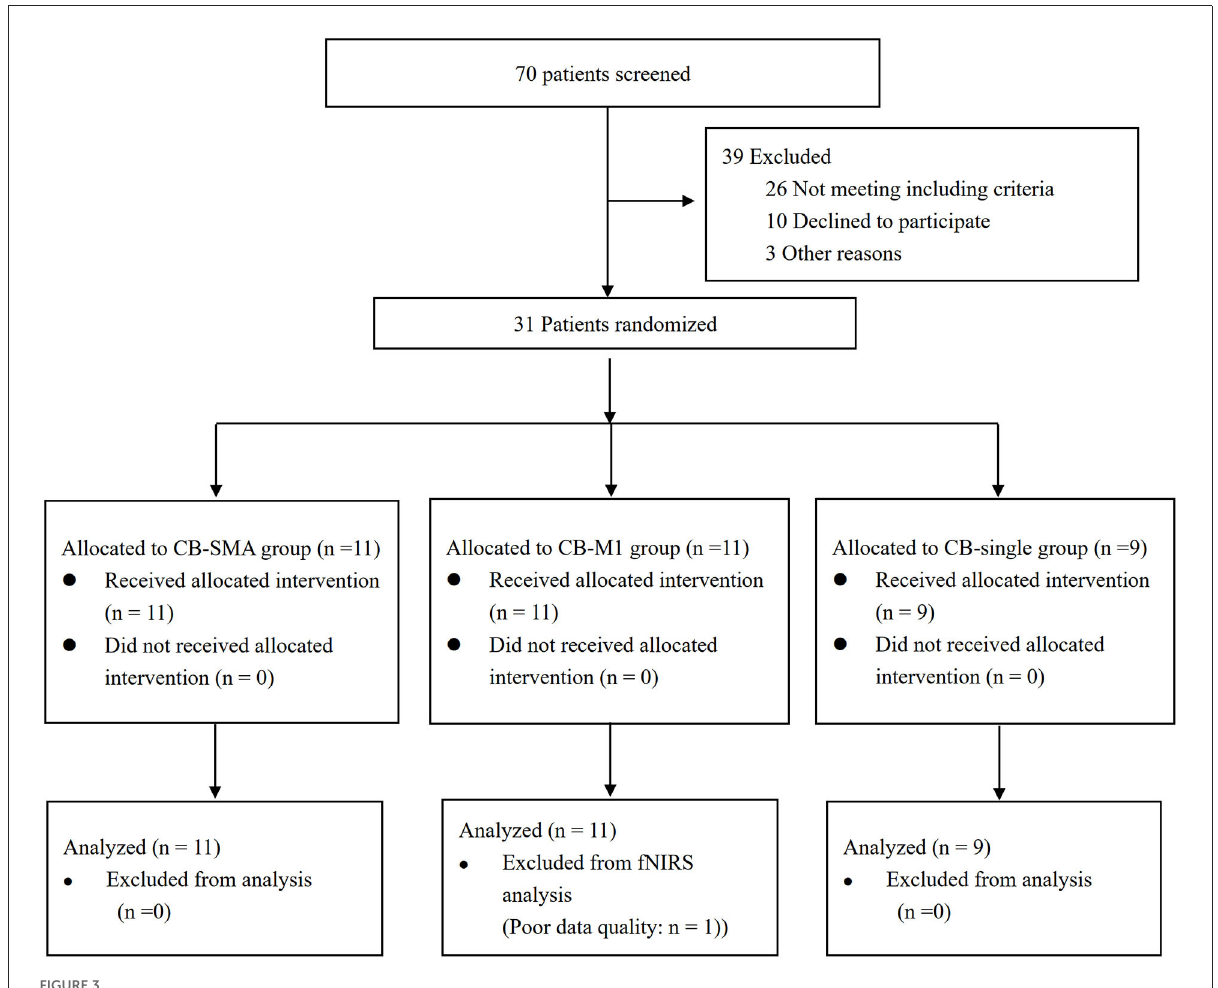
FIGURE3 CONSORT flow diagram of patients enrolled in the